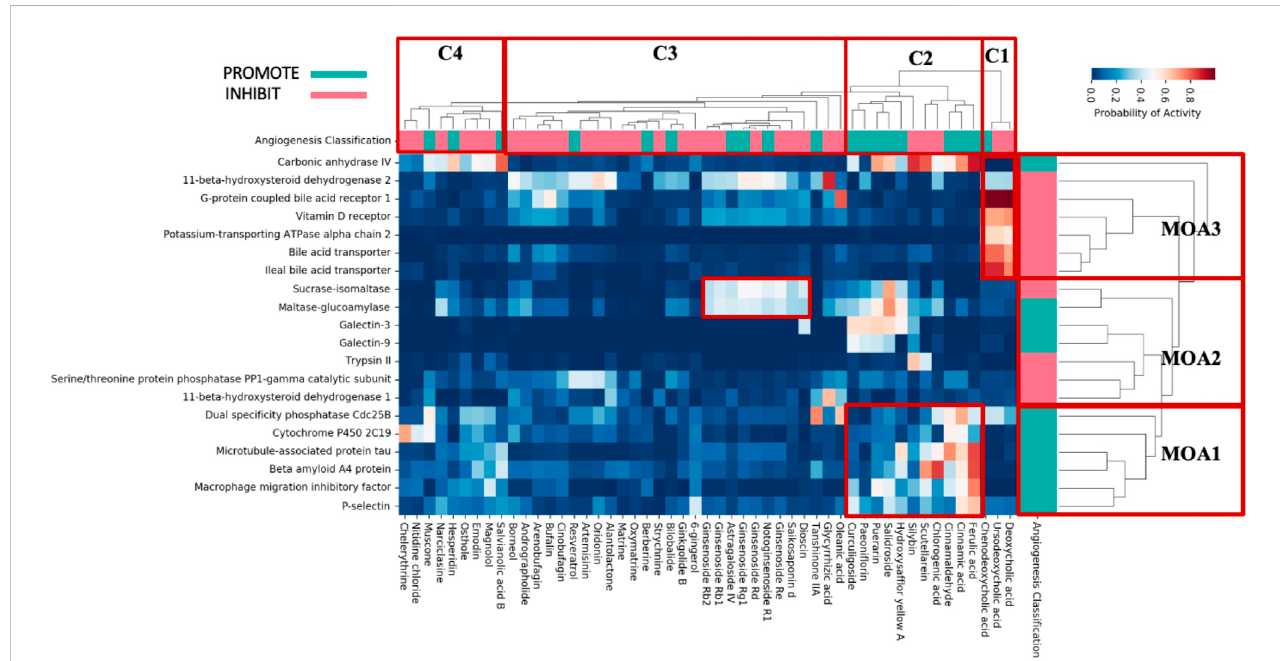
FIGURE 2 Protein bioactivities predicted by PIDGIN between individual TCM metabolites and most enriched targets. Individual metabolites were clustered based on the pro fi le of target prediction (C1 – C4); pink and green represent literature evidence for inhibition (INHIBIT) and promotion (PROMOTE) of angiogenesis, respectively, whilst the enriched anti-angiogenic (INHIBIT) and pro-angiogenic (PROMOTE) protein targets are shown in the MoA column on the right,